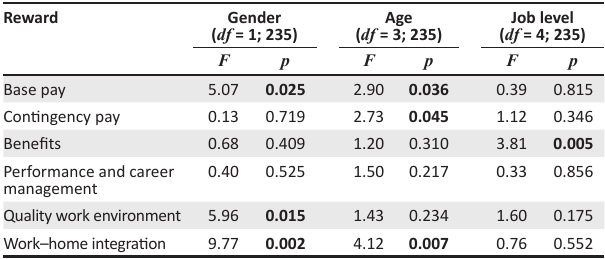
TABLE 6: Univariate analysis of variance